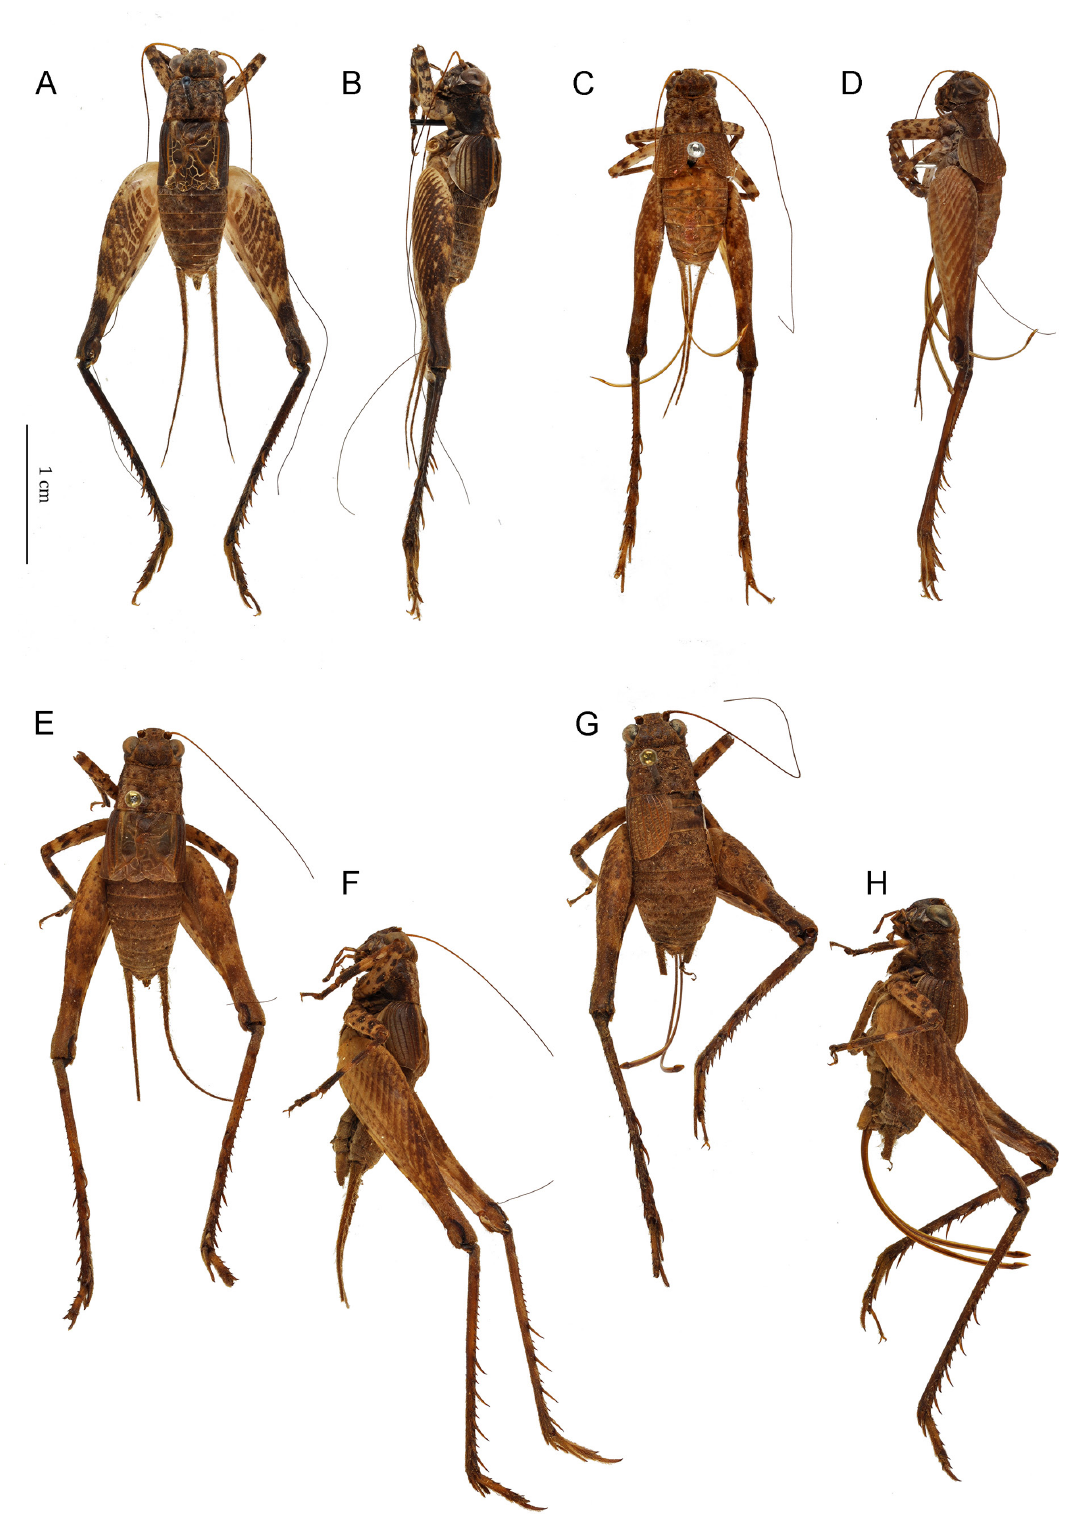
Fig. 4. Habitus. A–D . Platybinthus striolatus (Brunner von Wattenwyl, 1898) gen. et comb. nov. (♂ ZIN; ♀ MNHN-ENSIF1449). E–H . Platybinthus sandyi gen. et sp. nov. (♂ holotype MZB.ORTH.1786; ♀ paratype MZB.ORTH.1787). A–B, E–F . ♂♂ . C–D, G–H . ♀♀ . Scale bar = 1